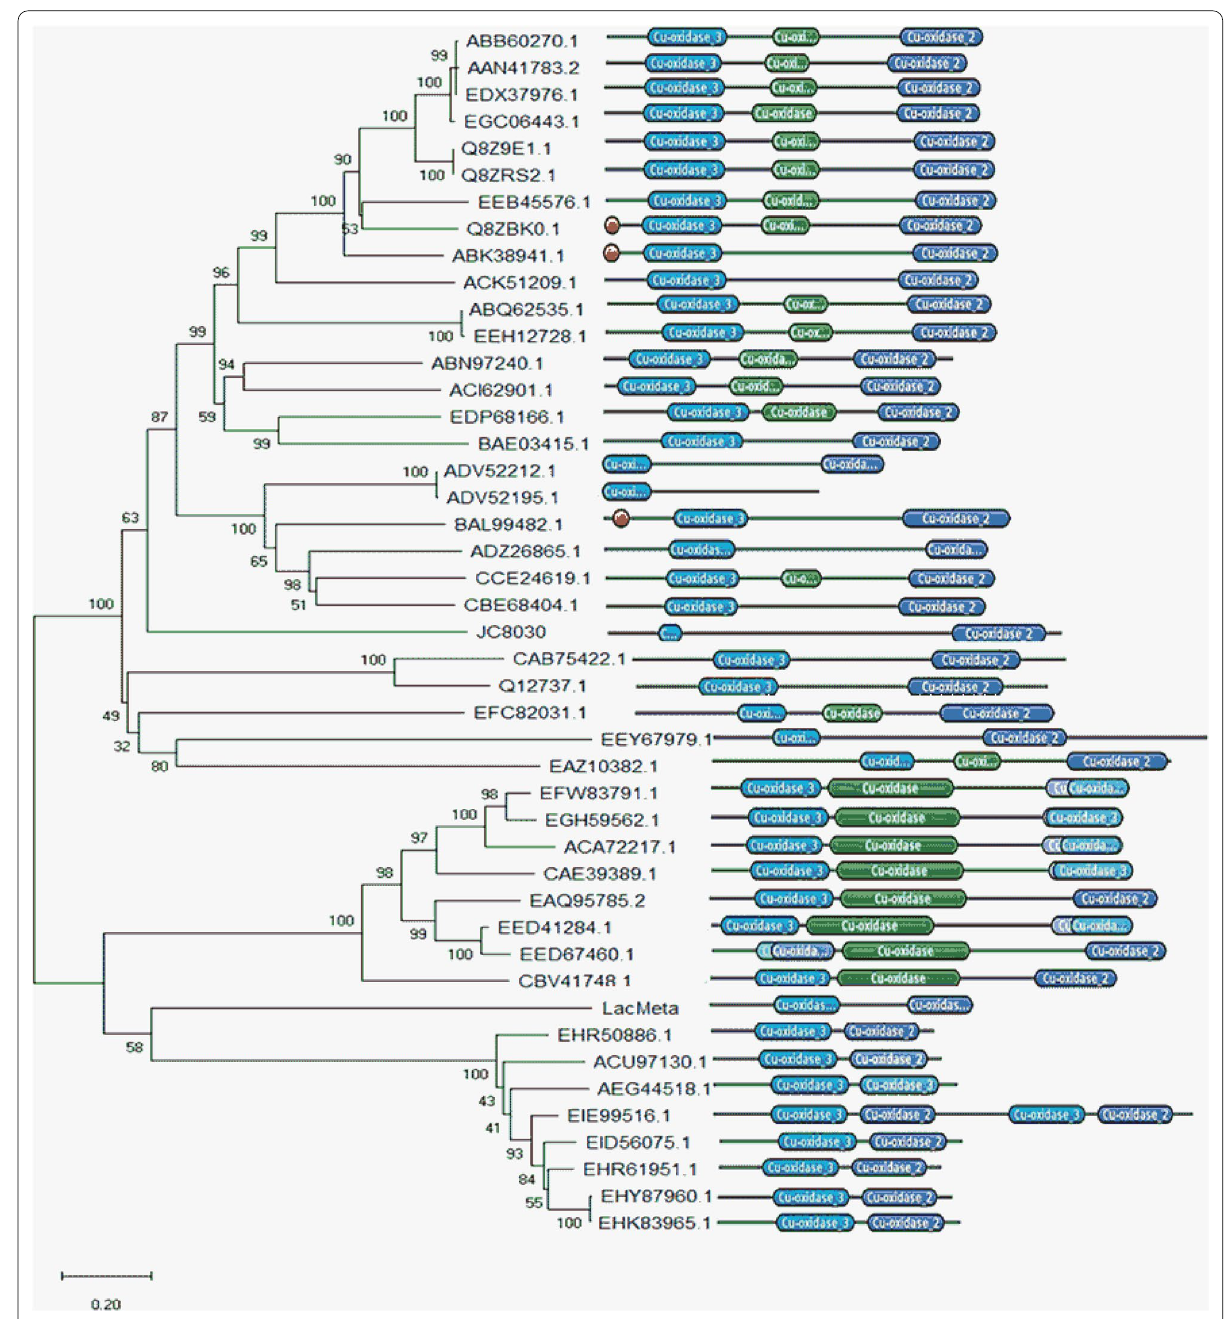
Fig. 1 Hierarchical dendrogram obtained for sequences of different families of laccases characterized and deposited in the “Laccase and Multicopper Oxidase Engineering Database,” LccED database, applied by the optimization method for close neighbors (neighbors joining). The domain mapping was followed by the DoMosaics program (Moore et al.